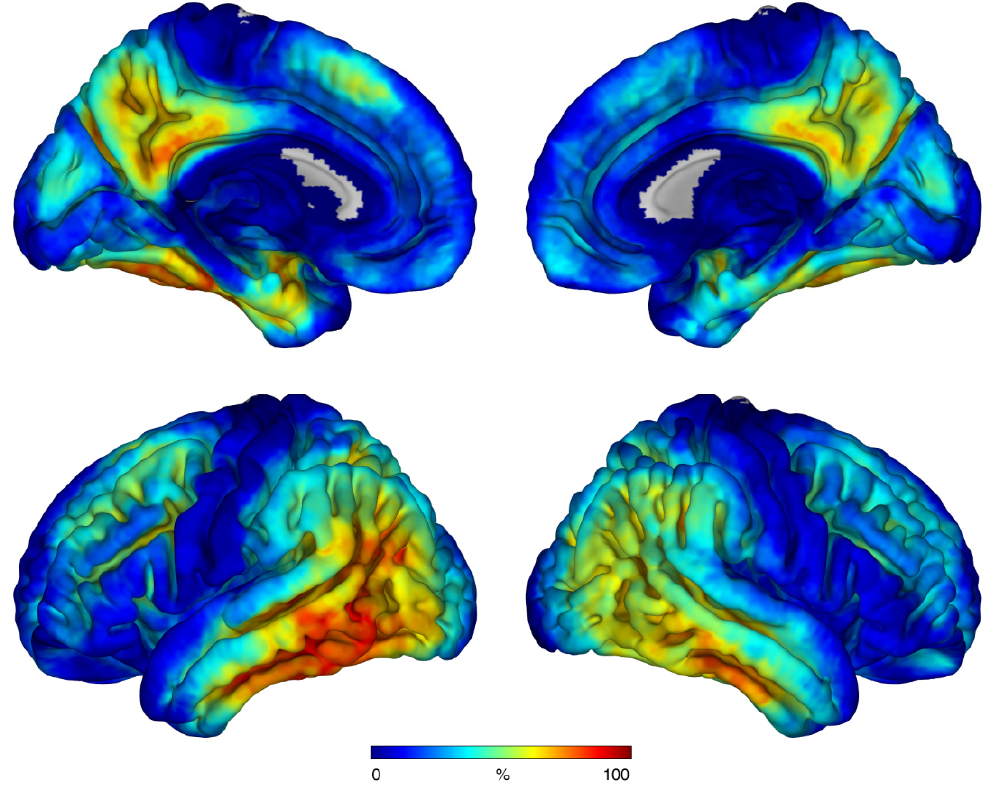
Figure 2. Voxel-wise frequency map of tau positivity of all voxels from all AD dementia cases projected on a cortex surface.